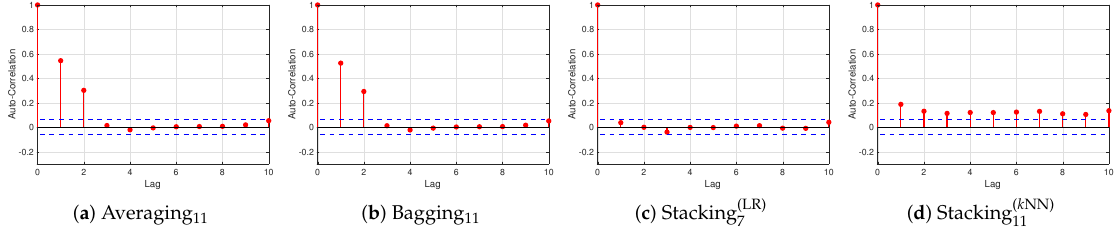
Figure 7. Autocorrelation of residuals for BTC dataset of ensemble models using CNN-BiLSTM as base